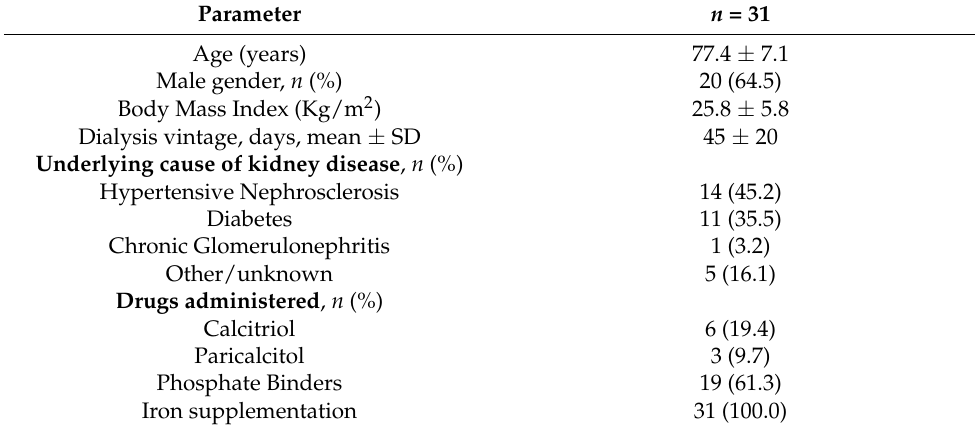
Table 1. Characteristics of